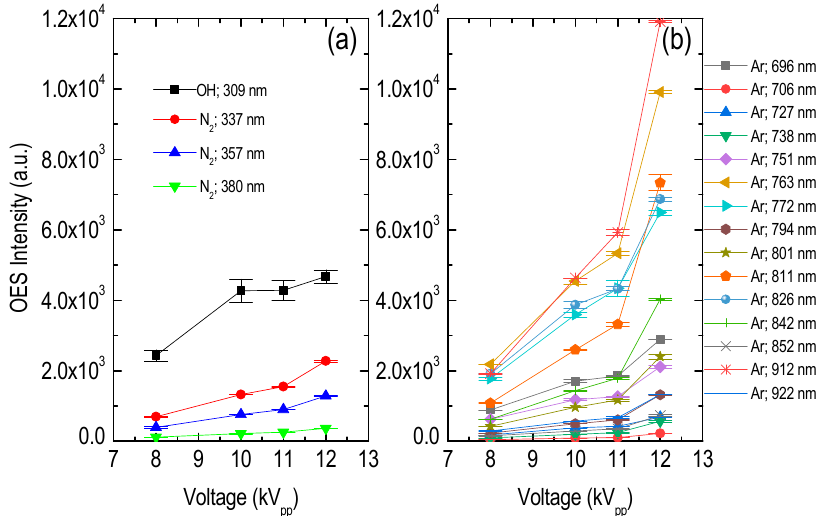
Figure 4. Optical emission intensity of the main emissive species detected as a function of the applied voltage amplitude. ( a ) N 2 and OH species. ( b ) Ar species. Operational conditions: 17.5 kHz and 1.5 slm. Mean values and standard deviations are calculated from two series of experiments carried out on different dates.